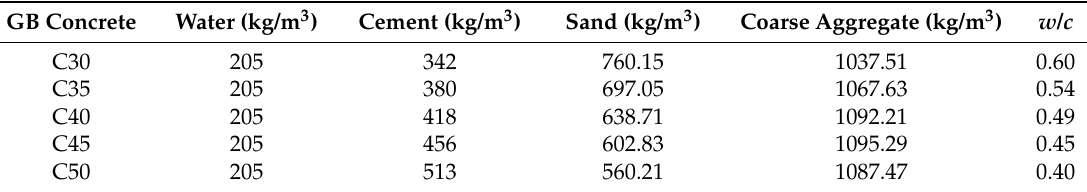
Table 1. Chinese Standard Concrete mix proportions.